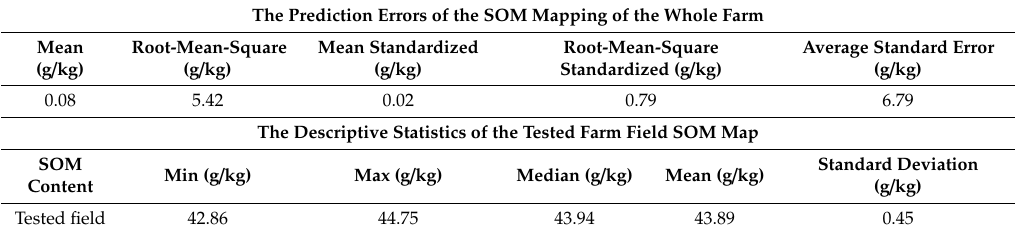
Table 1. The prediction errors of the soil organic matter (SOM) mapping of the whole farm and the descriptive statistics of the tested farm field SOM map.